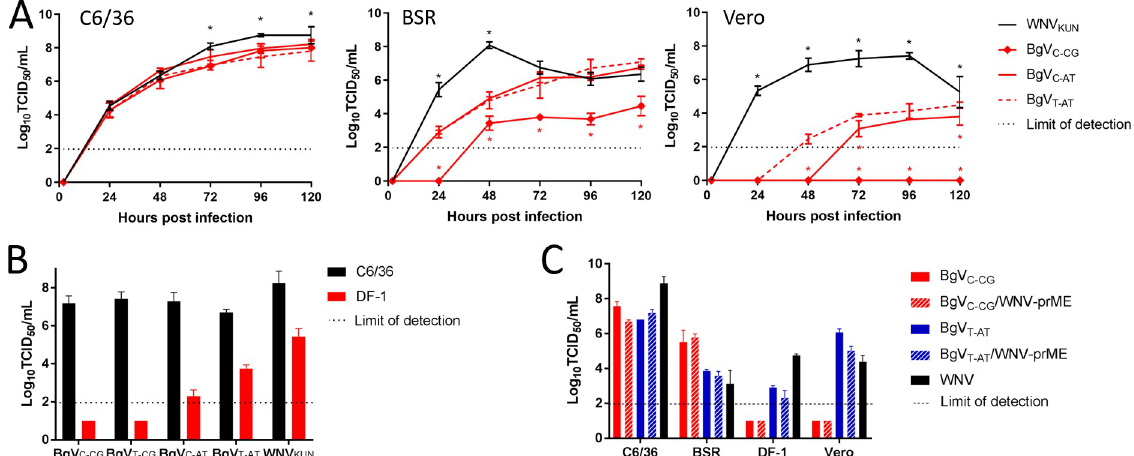
triplicate at MOI 1 and incubated at 28˚C (C6/36) or 37˚C (DF-1). The supernatants were harvested after five days, titrated on C6/36 cells and the titres determined by fixed cell ELISA. The error bars represent the standard deviation and the dotted line represents the lower limit